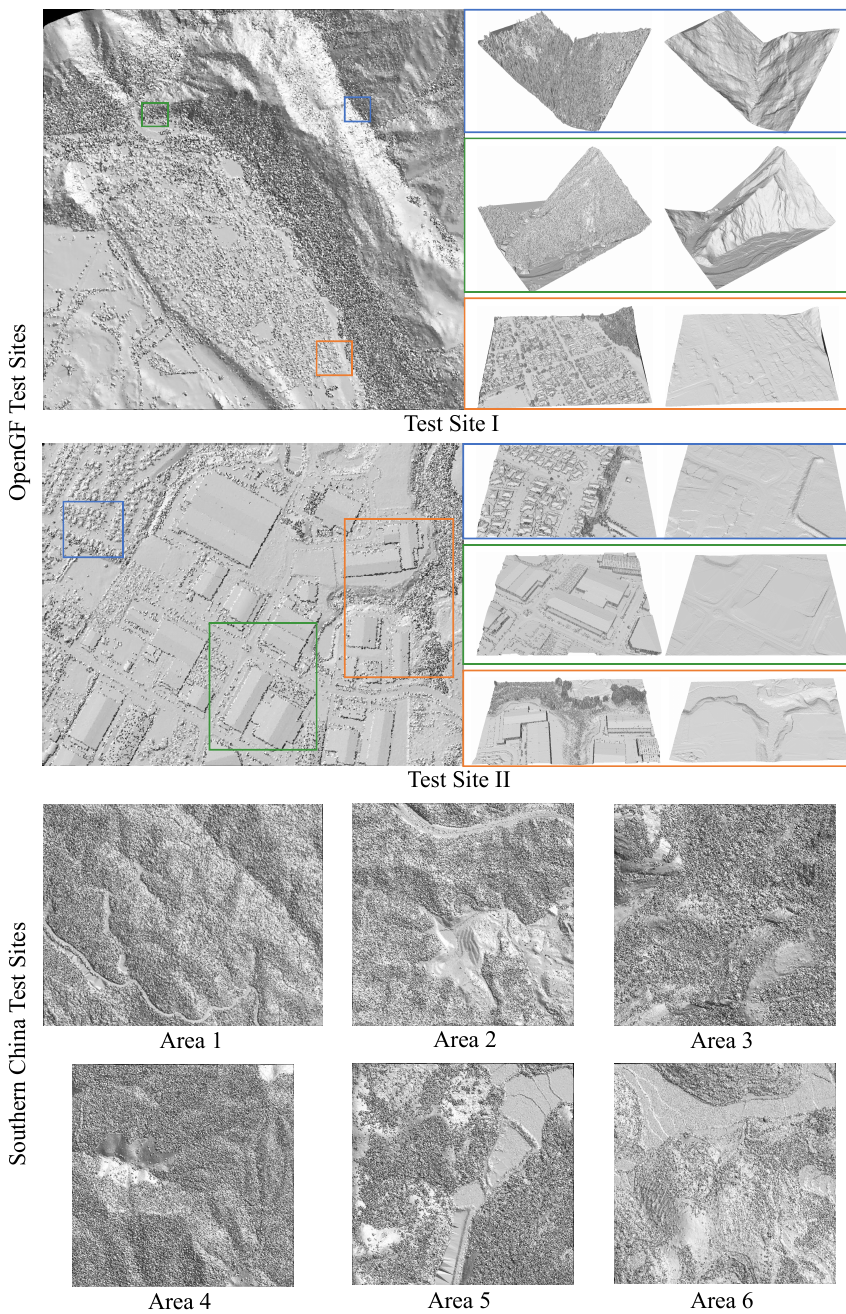
Figure 1. The test sites of OpenGF dataset and Southern China